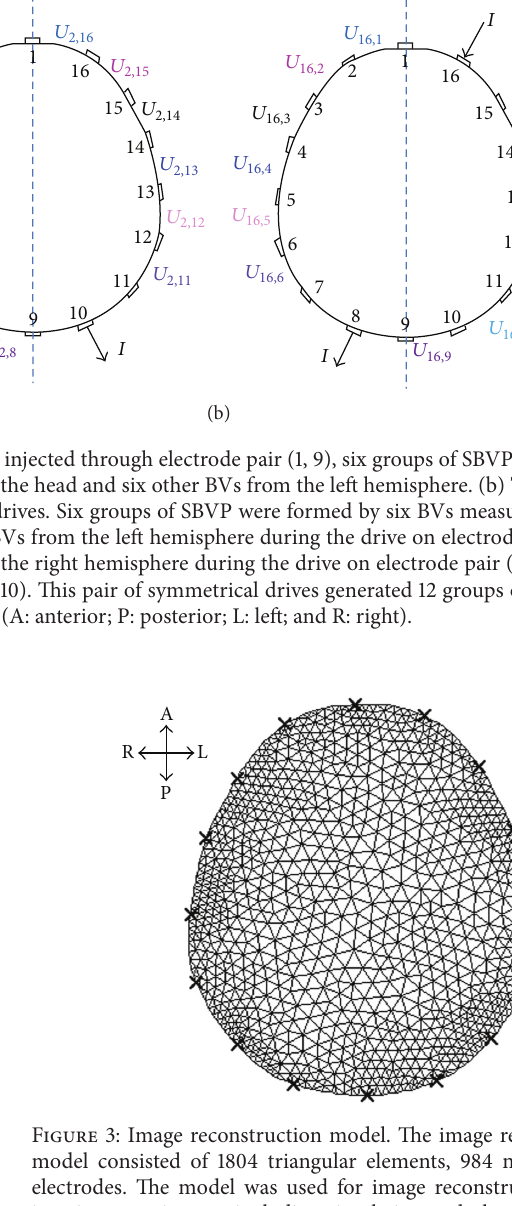
first row) had a relationship with the remaining 96 BVs 𝑈 𝑖 󸀠 ,𝑗